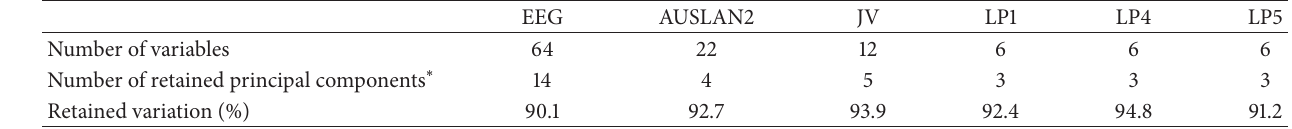
Table 3: Contribution of principal